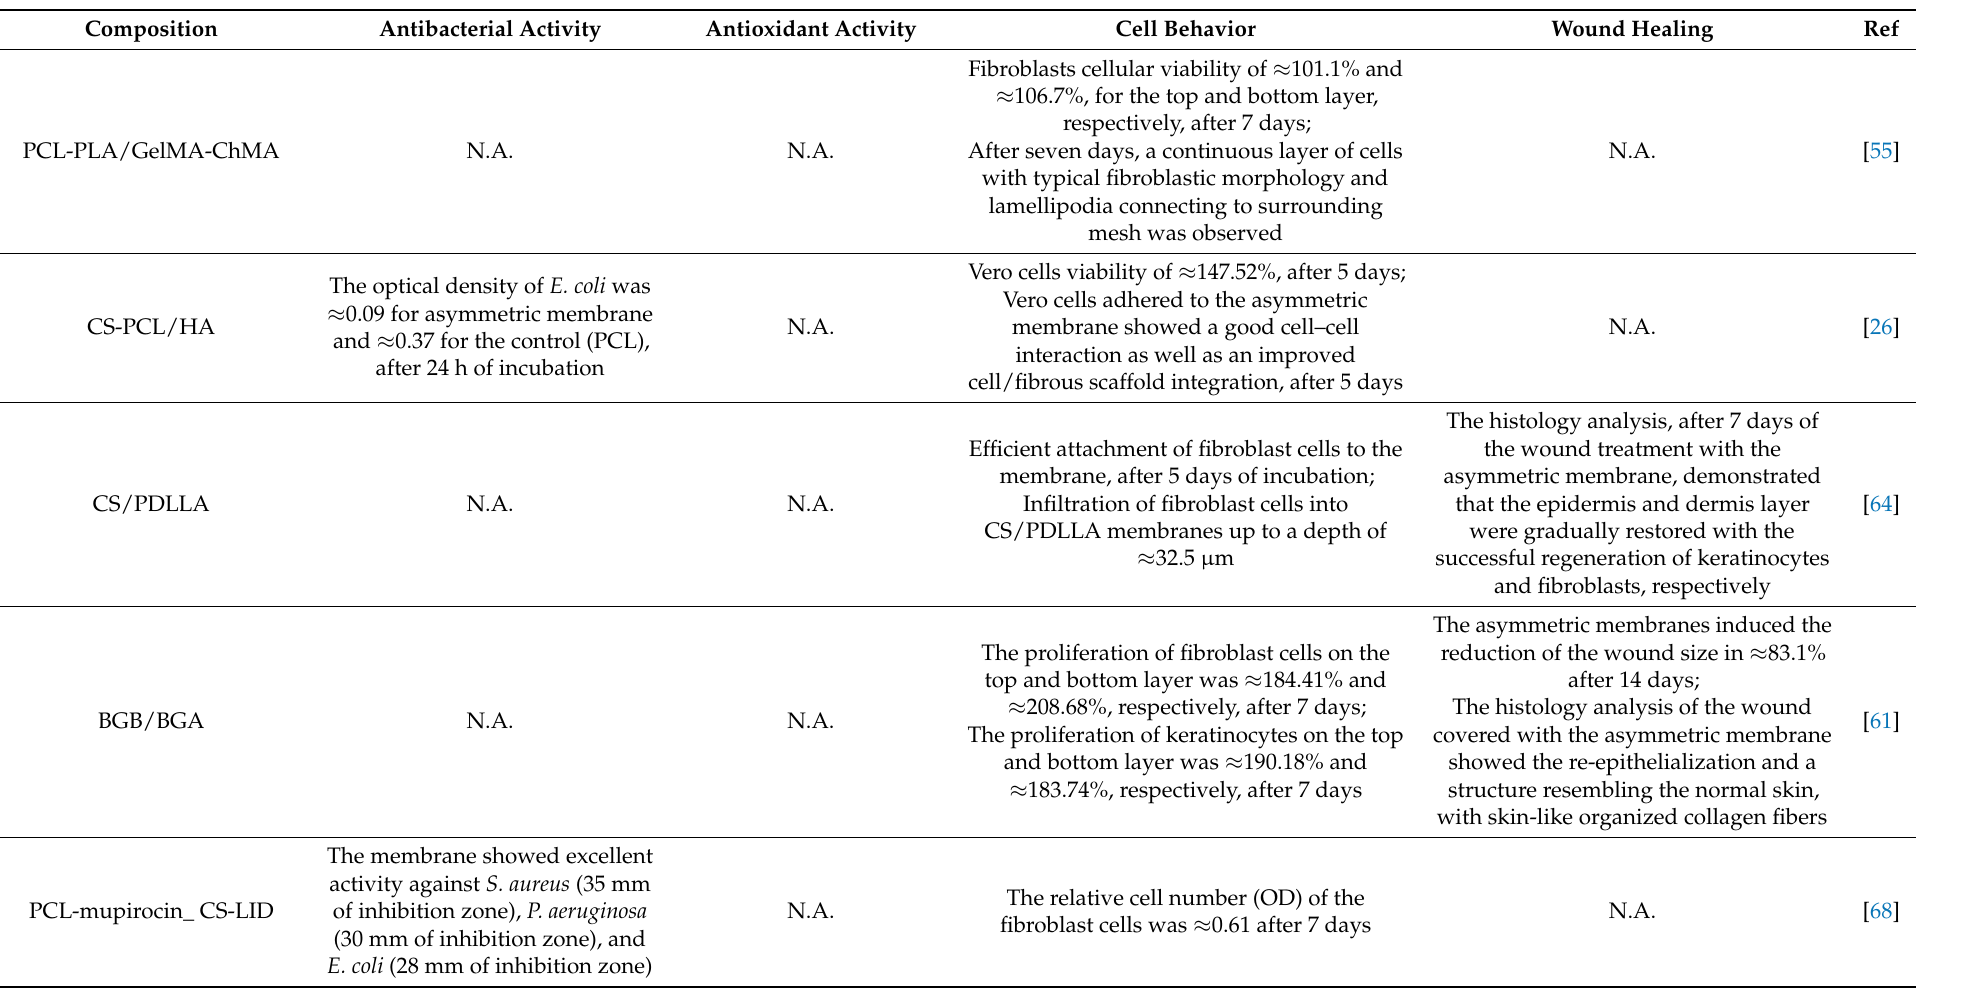
Table 2. Biological performance of the asymmetric membranes produced through electrospinning aimed to be used as wound